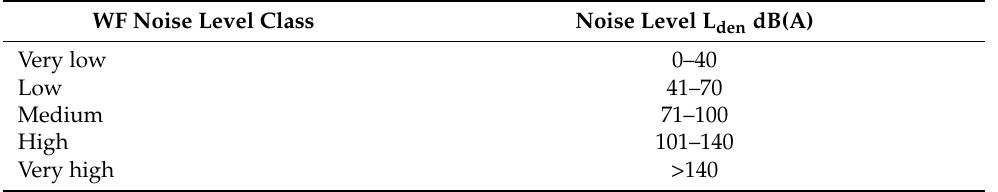
Table 3. Noise levels classification.